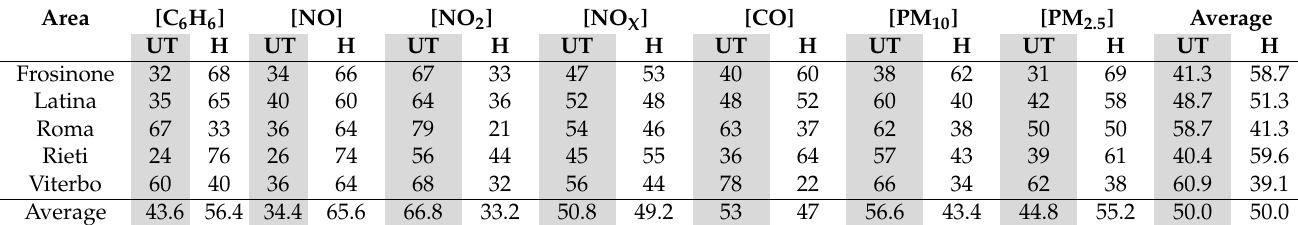
Table 14. Daily mean percentage of urban traffic (UT) and building heating systems (H) for each pollutant concentration and